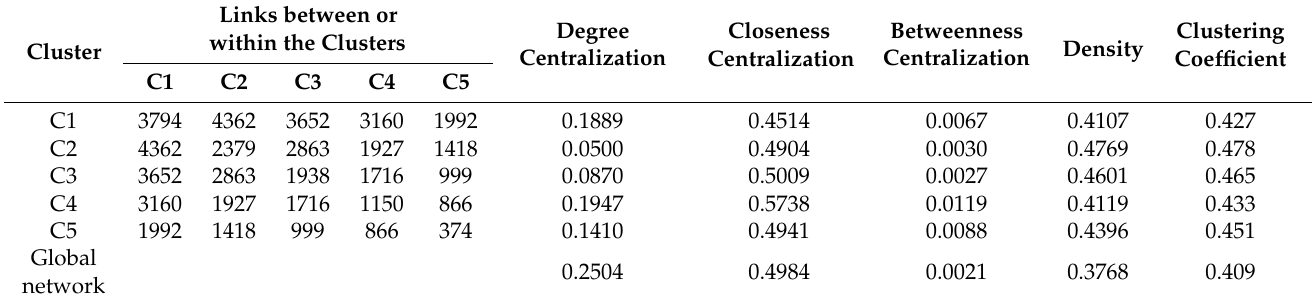
Table 6. Associations and network indicators of the five clusters.